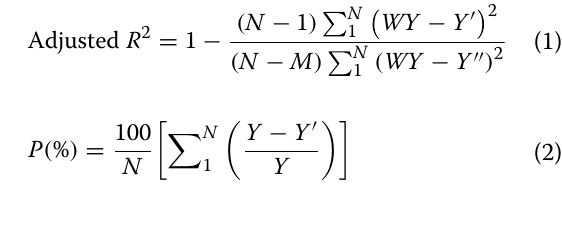
Table 2 Isotherm models used to describe the sorption behavior of karaya gum Isotherm